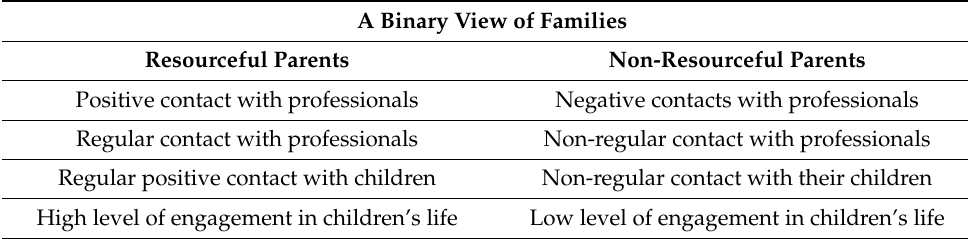
Table 3. The binary view of